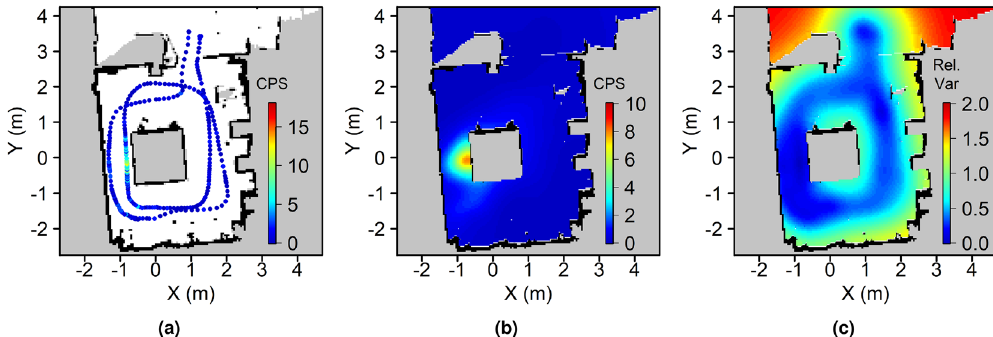
Figure 4. SLAM generated occupancy grid for the Lancaster University Neutron Laboratory, with spatially- resolved radiation count rate observations superimposed ( a ), and the interpolated map of radiation intensity ( b ). Blue indicates low (background) to red indicating higher counts per second. Part ( c ) shows relative estimate confidence, with blue indicating high confidence (low relative variance) and red indicating low confidence. (All plots generated using R version 3.6.1 43 https:// cran.r- proje ct. org/ bin/ windo ws/ base/ old/3.